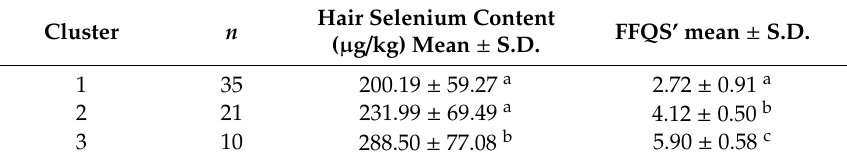
Grains *: after adjustment for rice and wheat. Table 4. The average hair selenium content and FFQS’ of the three clusters. Hair Selenium Content FFQS’ mean ± Cluster n ( µ g / kg) Mean ± S.D.